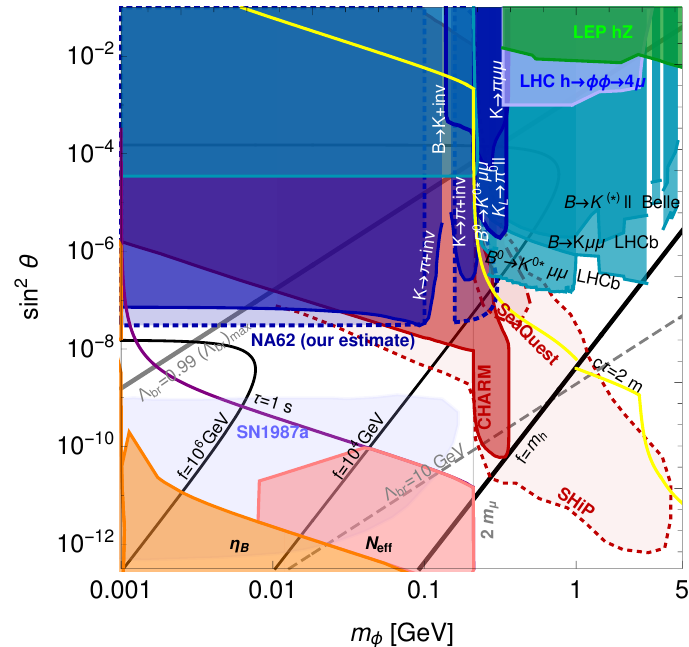
Figure 3 . Constraints on the relaxion-Higgs mixing sin 2 (cid:18) for relaxions with m (cid:30) between MeV and 5 GeV. The laboratory probes include: proton beam dump experiments (red for CHARM, light red for the projected sensitivity for SHIP and SeaQuest), K -meson decays (blue, our conservative projection from NA62 in a lighter shade of blue), B -meson decays (turquoise), LHC search for h ! 4 (cid:22) (light blue) and LEP (green). Astrophysical and cosmological probes include the Supernova 1987a (pale violet, labelled as SN), (cid:17) b (orange) and N e(cid:11) ( pink). Contours for (cid:3) br = 0 : 99(cid:3) max 104 GeV (gray, thick, solid), (cid:3) br = 10 GeV (gray, dashed), f= GeV = 10 6 ; 10 4 ; 125 (black, solid) are presented. Here (cid:3) max is the upper bound on (cid:3) br arising from the requirement of a non-tachyonic (cid:30) p br in eq. (3.12) for sin( (cid:30) 0 =f ) = 1 = 2. The vertical light gray line corresponds to the contour for the relaxion mass at the muon threshold; the yellow contour corresponds to c(cid:28) = 2 m and the purple one to (cid:28) = 1